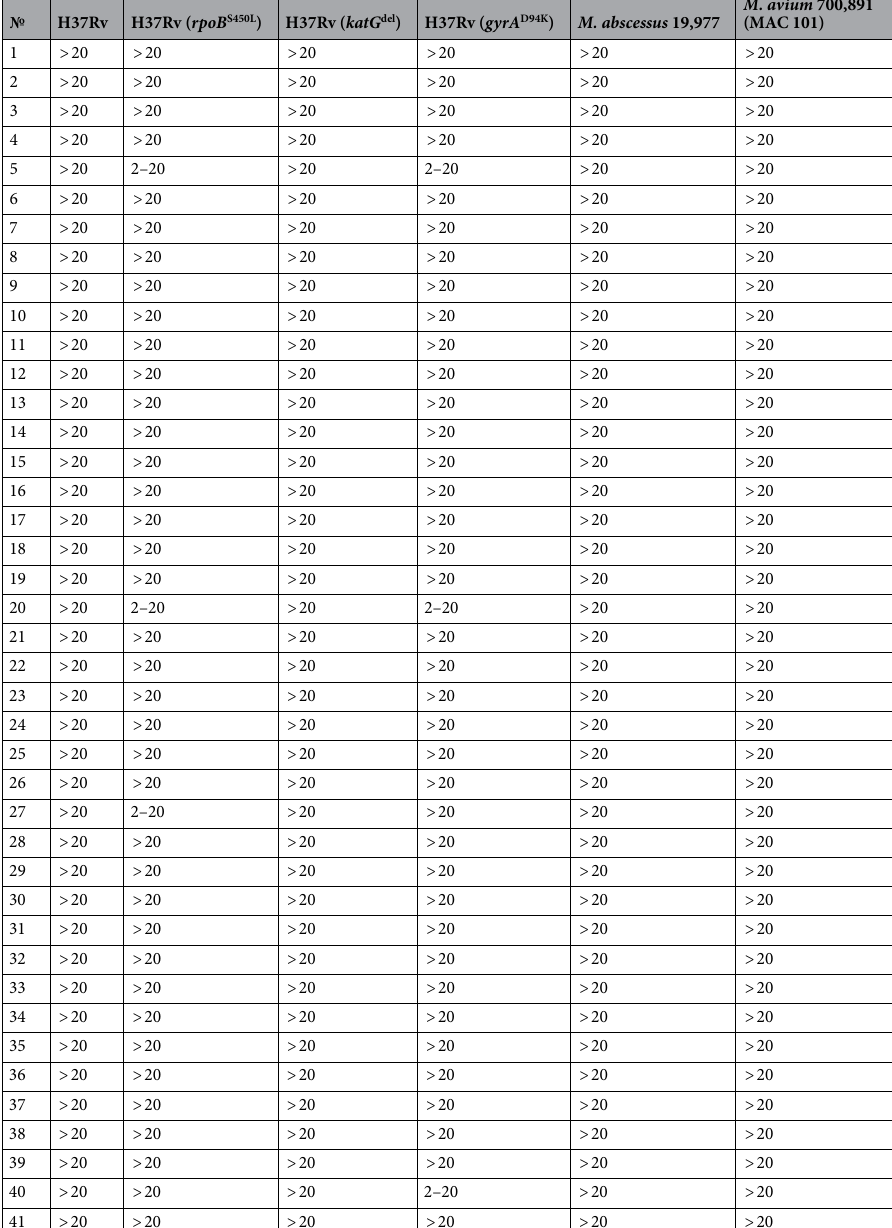
Table 3. Growth inhibition cutoffs of compounds against M. tuberculosis strain